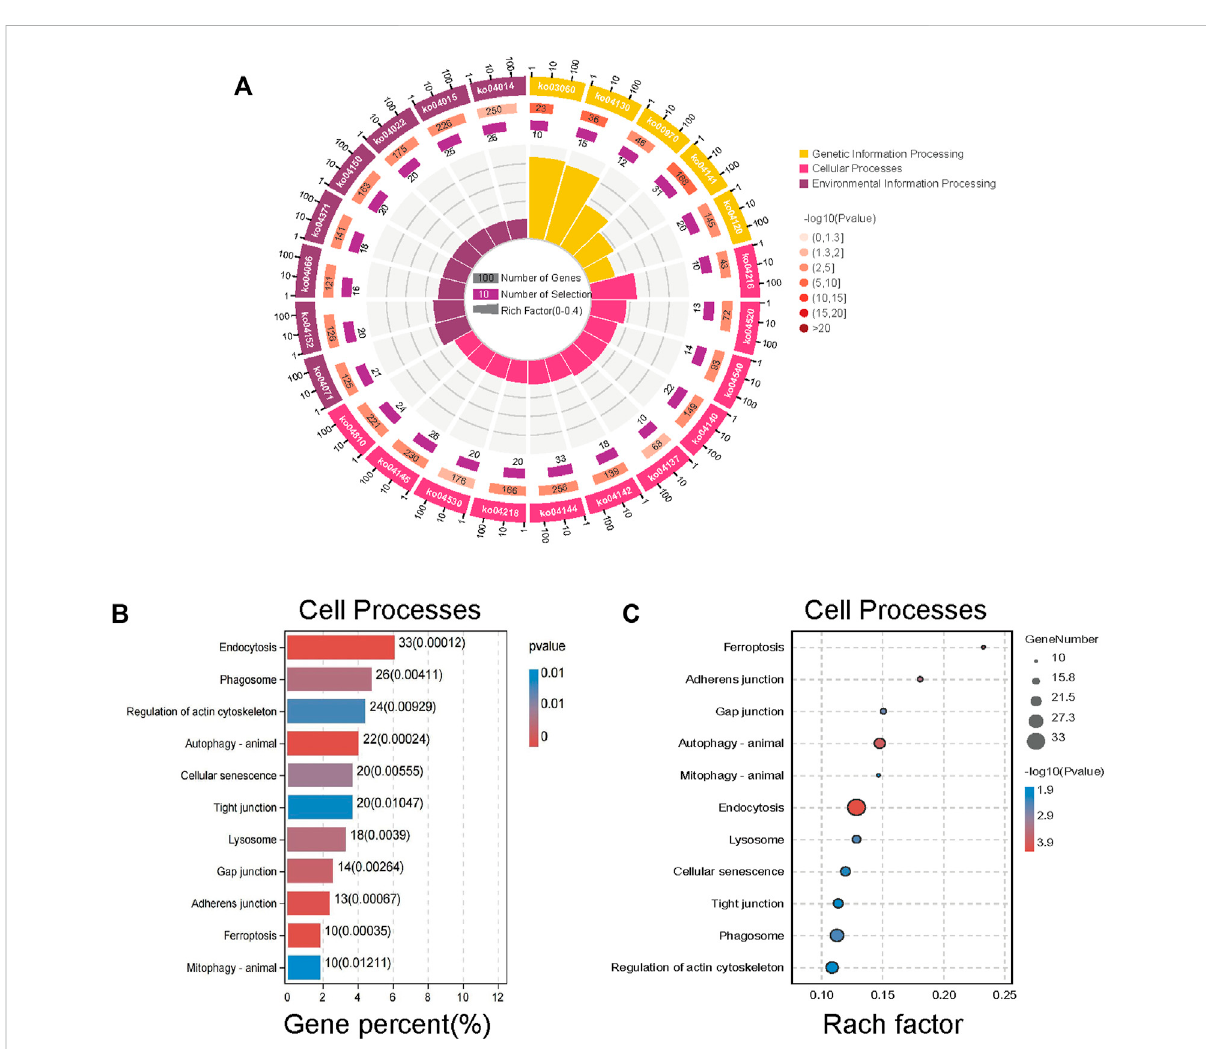
FIGURE 4 Kyoto Encyclopedia of Genes and Genomes (KEGG) enrichment analysis of different proteins expression. (A) An enrichment circle diagram shows the different classi fi cations of KEGG enrichment analysis. (B) The bar chart of Cellular Processes, which are sorted by Gene percent,show the fi rst 11 pathways of Cellular Processes. (C) The bubble chart of Cellular Processes, which are sorted by Rach factor,show the fi rst 11 pathways of Cellular Processes. The more red the color, the lower the p value and the higher the con fi